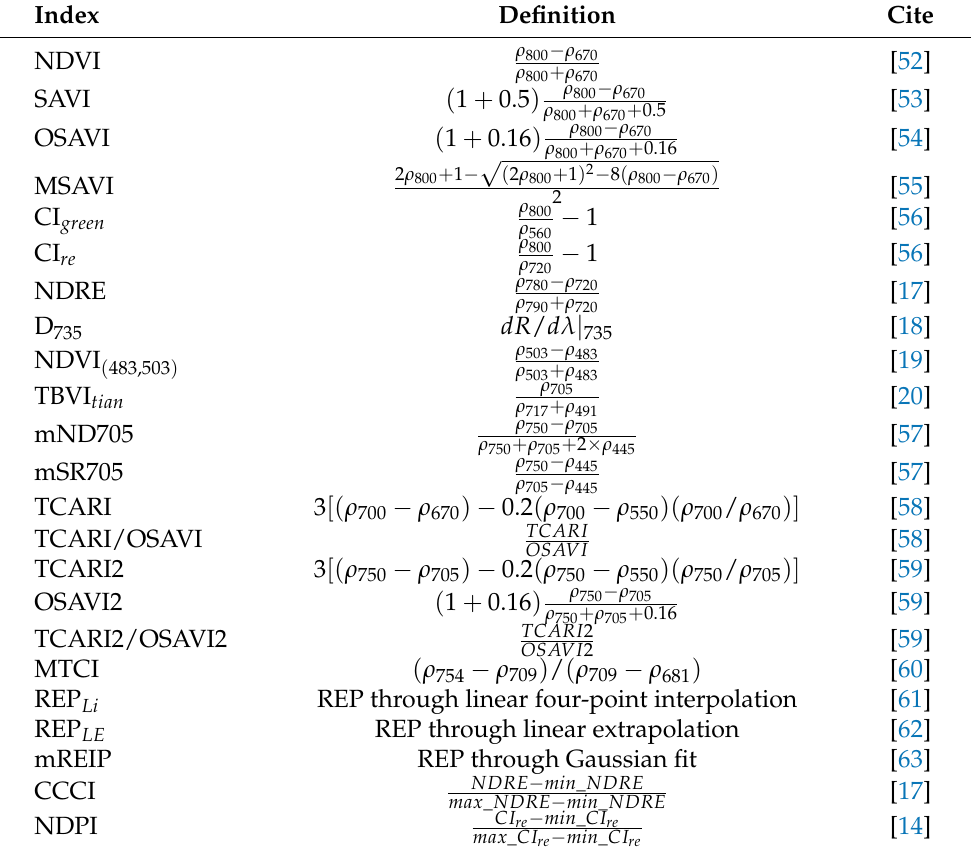
Table 1. VIs evaluated in this